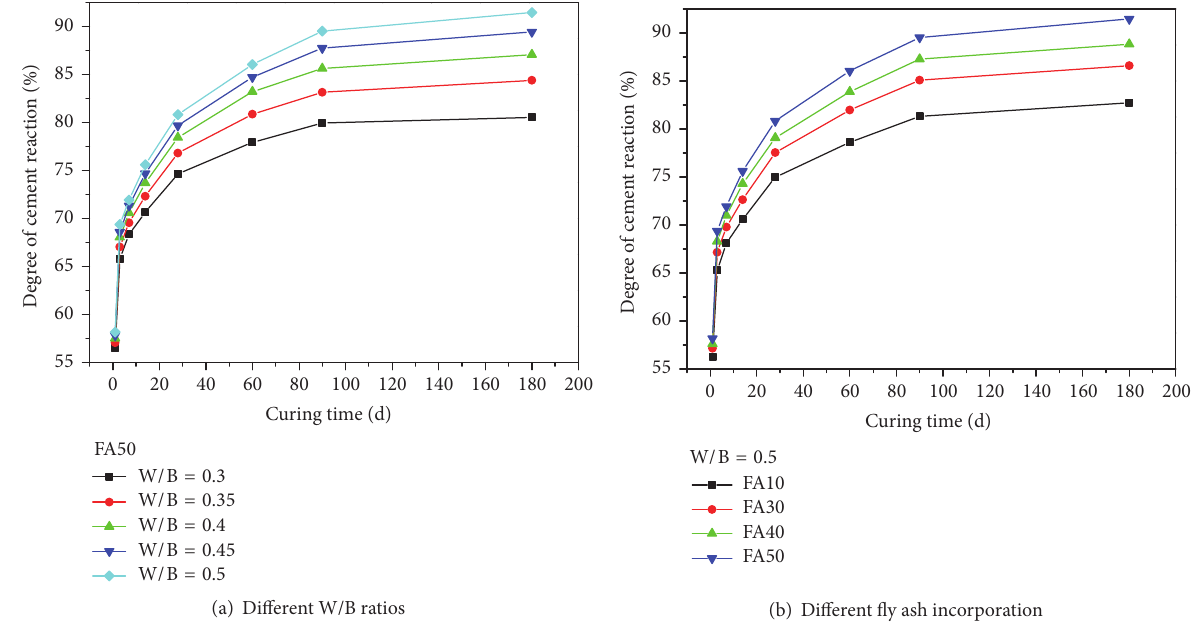
Figure 6: The fly ash reaction degree of fly ash-cement system.